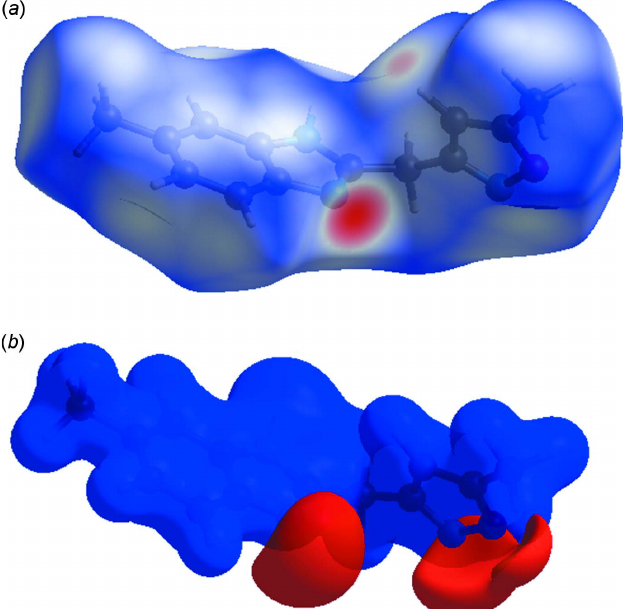
Figure 3 ( a ) View of the three-dimensional Hirshfeld surface of the title compound, plotted over d norm in the range (cid:4) 0.6149 to 1.3177 a.u. ( b ) View of the three-dimensional Hirshfeld surface of the title compound plotted over electrostatic potential energy in the range (cid:4) 0.0500 to 0.0500 a.u. using the STO-3 G basis set at the Hartree–Fock level of theory.